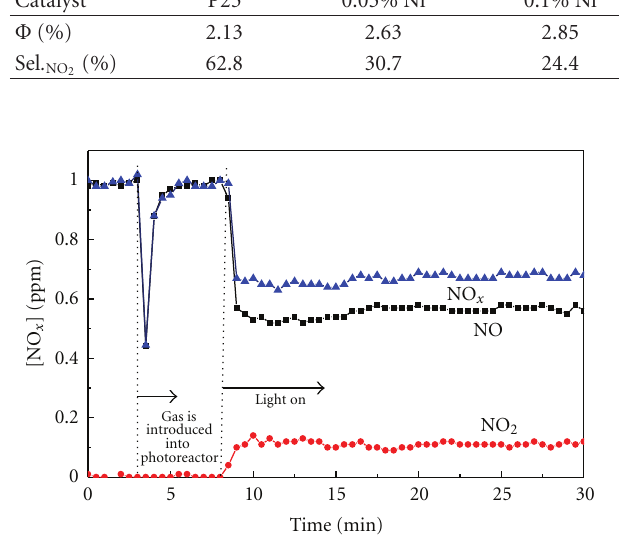
Figure 2: Time-course of the changes in concentration of NO, NO 2 , and NO x in the presence of 0.1% Ni-TiO 2 under UV light, reaction conditions as given in Table